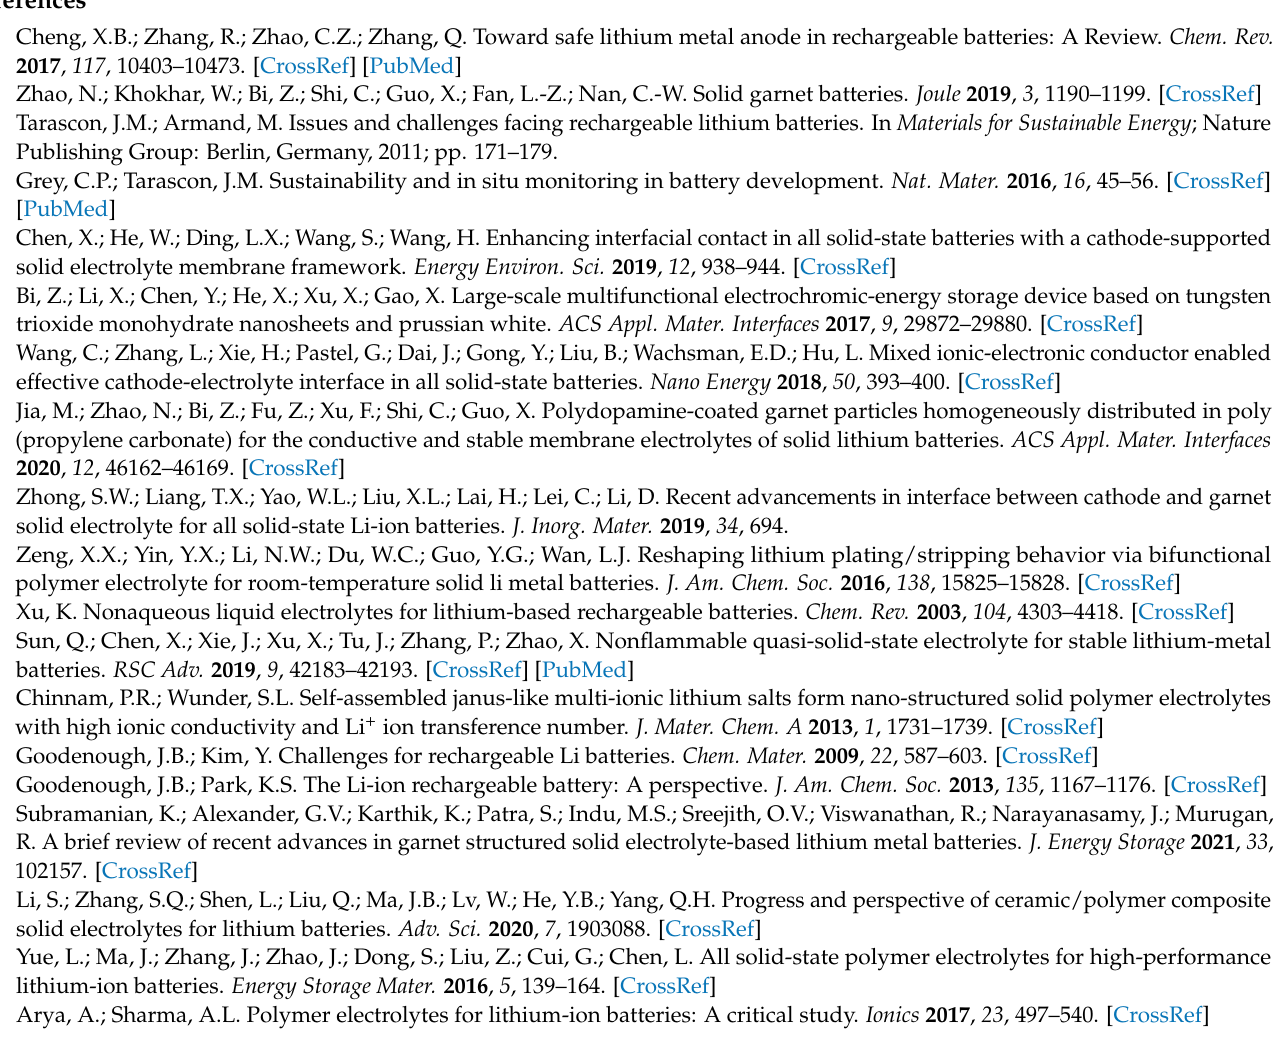
Table S2: Nyquist plots fitted data for lithium symmetric cells. Table S3: Nyquist plots fitted data for hybrid solid-state full